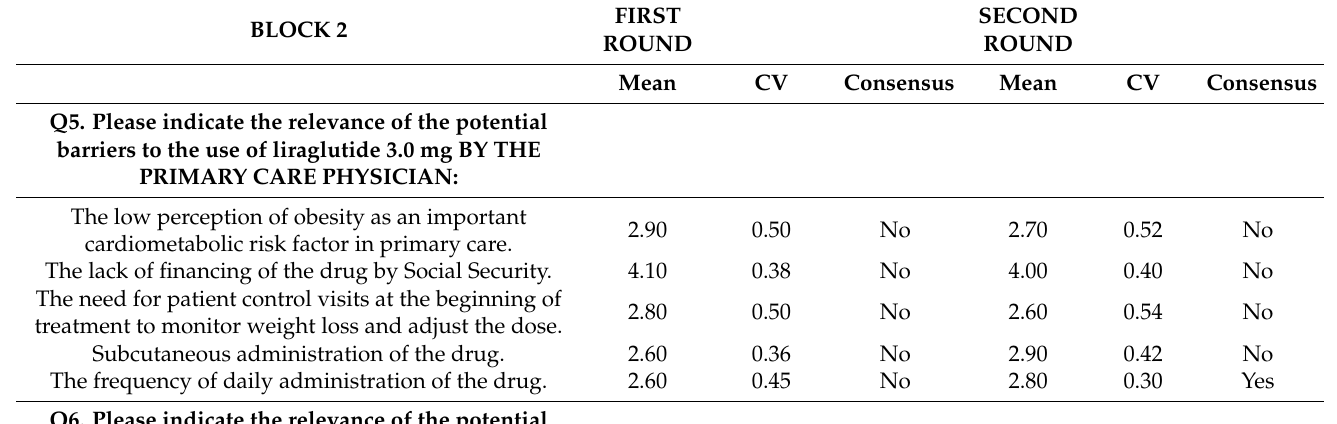
Table 1. Response-ordering questions. CV: Coefficient of